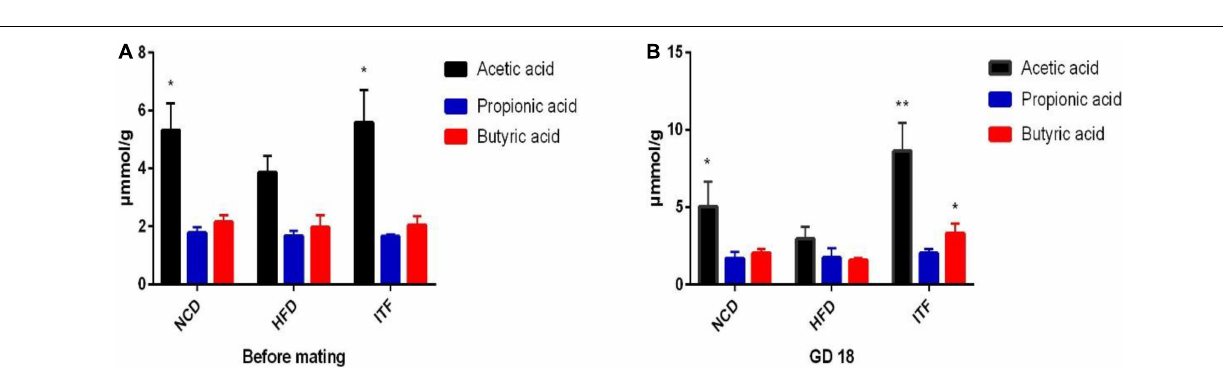
FIGURE 9 | (A) SCFA data before mating. (B) SCFA data on GD18. Data were analyzed using one-way ANOVA followed by the Tukey post hoc test for panels (A,B) . * p < 0.05, ** p < 0.01 compared to